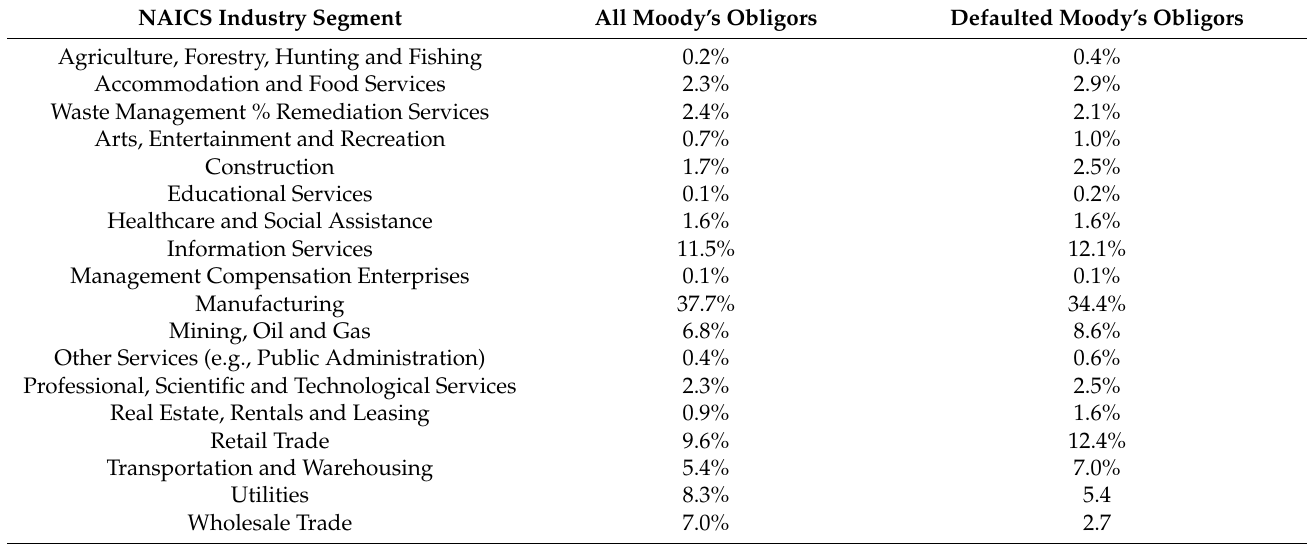
Table 2. Large Corporate Modeling Data—NAICS Industry Segment Composition for All Moody’s Obligors vs. Defaulted Moody’s Obligors